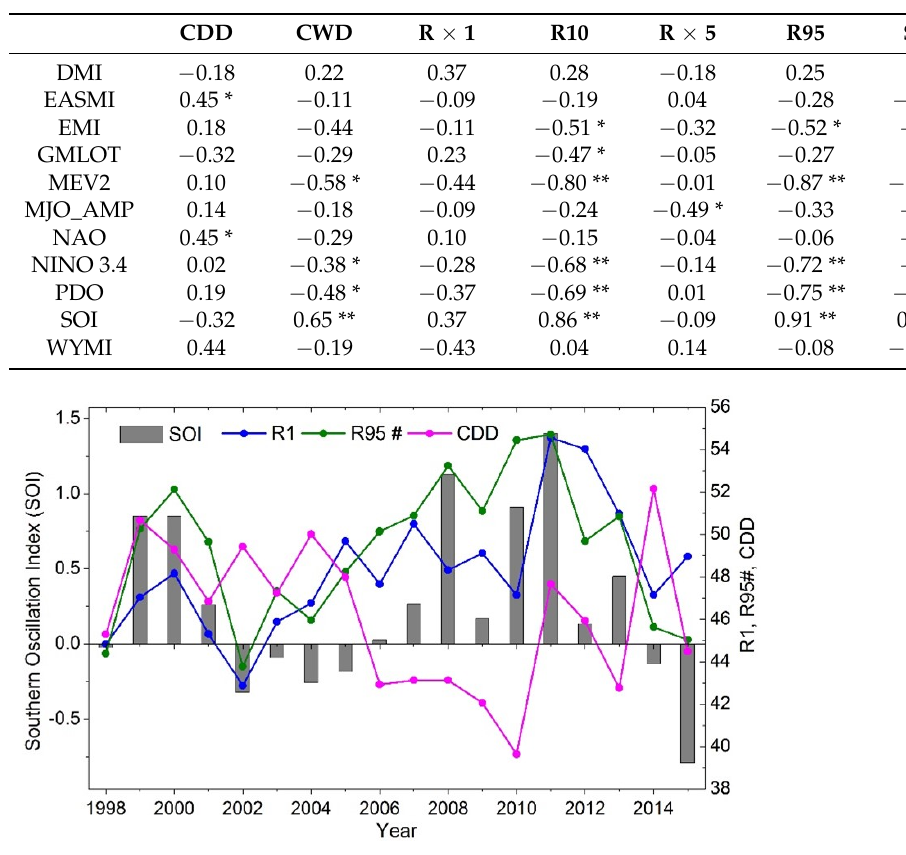
Figure 7. The Southern Oscillation Index (SOI) influences R × 1, R95, and CDD over the study region. Note: actual R95 is normalized as R95#= (R95/10)*2.